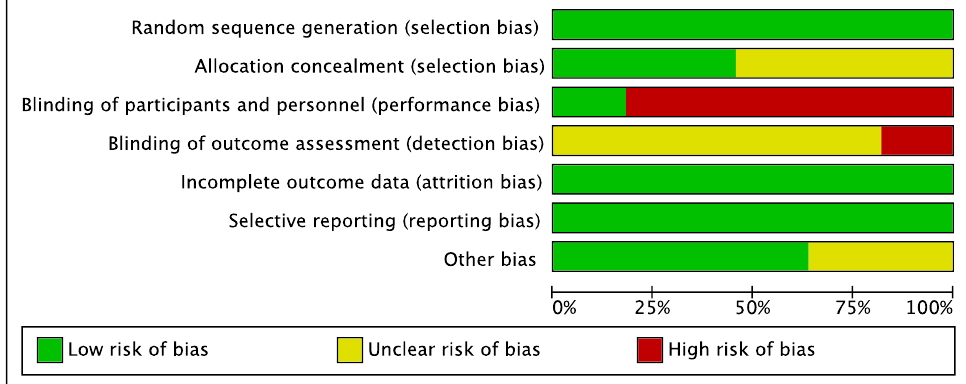
Figure 2. Risk of bias graph.